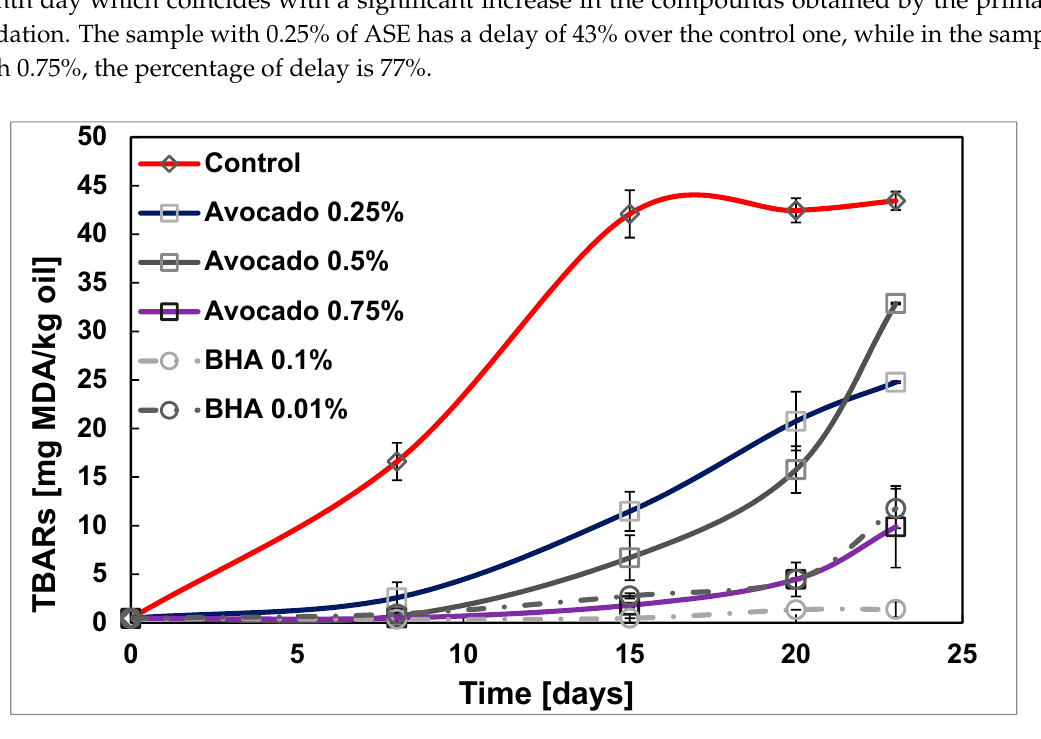
Figure 3. Changes in the TBARs value of sunflower oil fatty acid mixture at 35 °C in the dark.